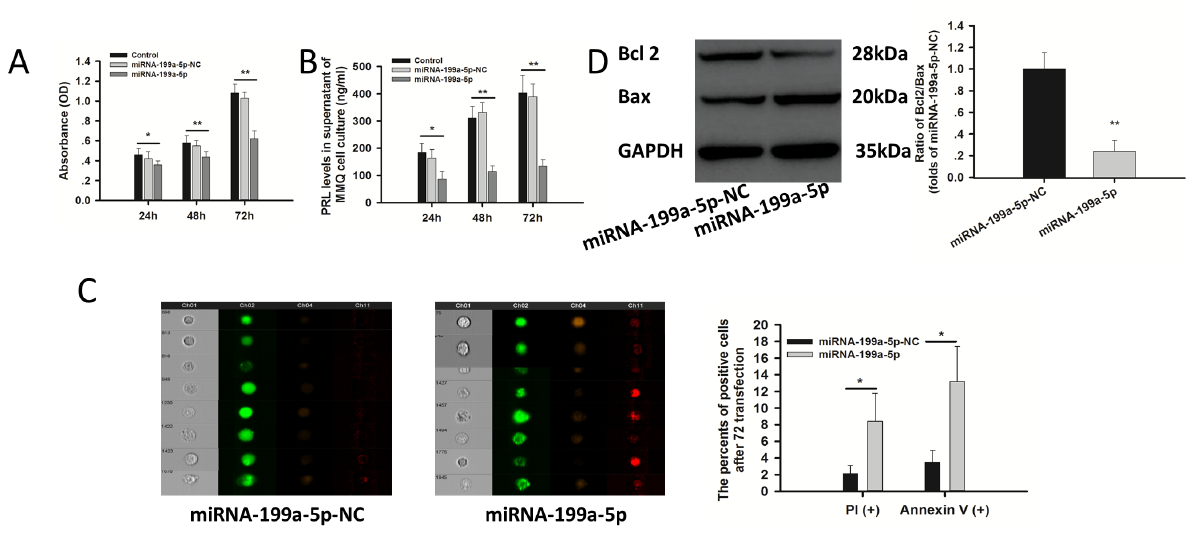
Figure 5: miRNA-199a-5p acted as an anti-tumor miRNA in MMQ cells. A: The effect on cell viability by MTS experiment. B: The effect on PRL secretion. C: The effect on apoptosis assessed by the Annexin V & PI apoptosis detection kit with MARK II. Green: GFP; Orange: PI; Red: Annexin V. D: Western blots of Bcl-2 and